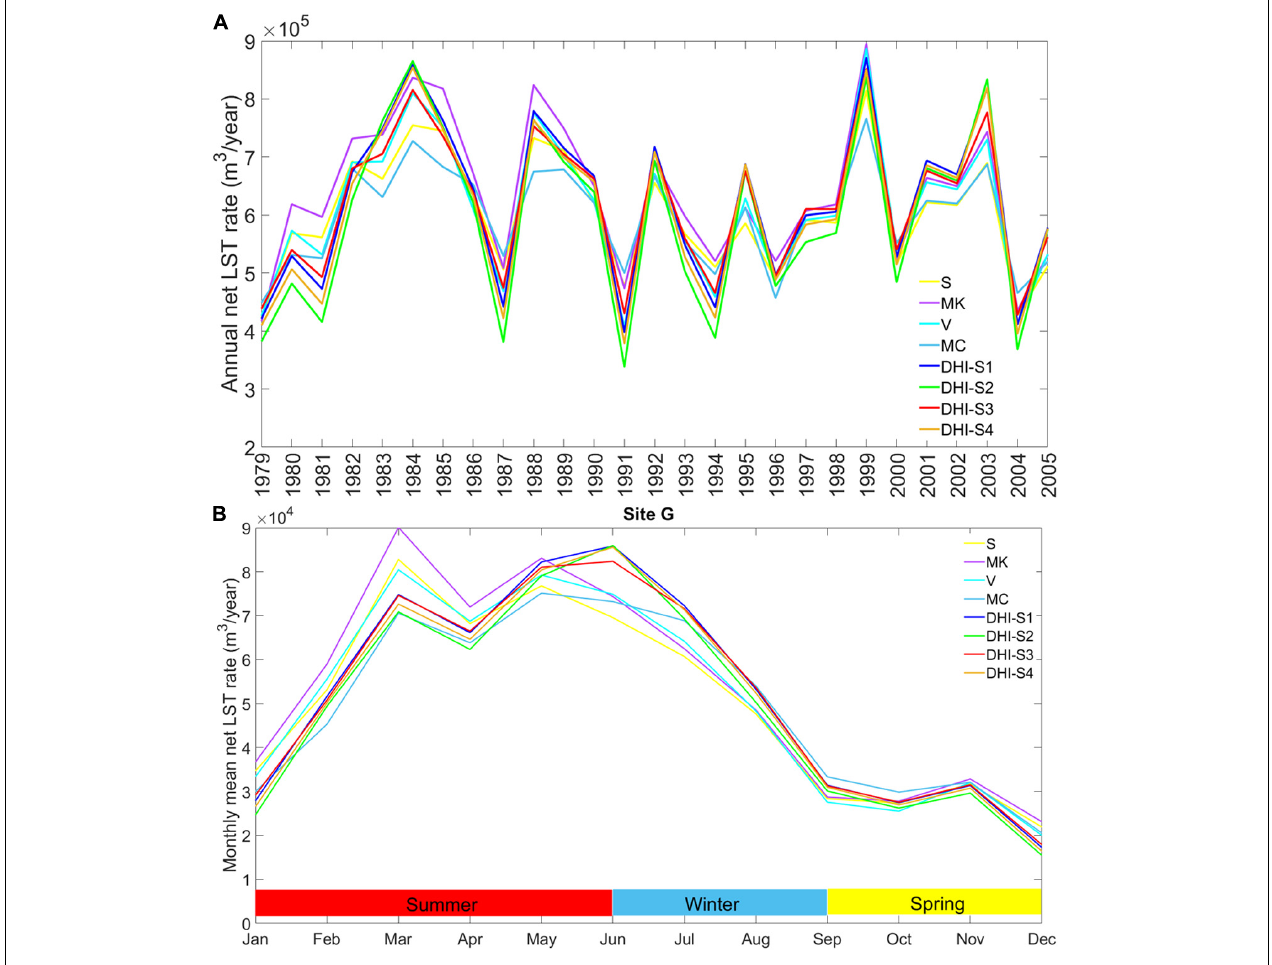
FIGURE 4 | (A) Inter-annual and (B) Intra-annual response of the calibrated LST models to the reference forcing